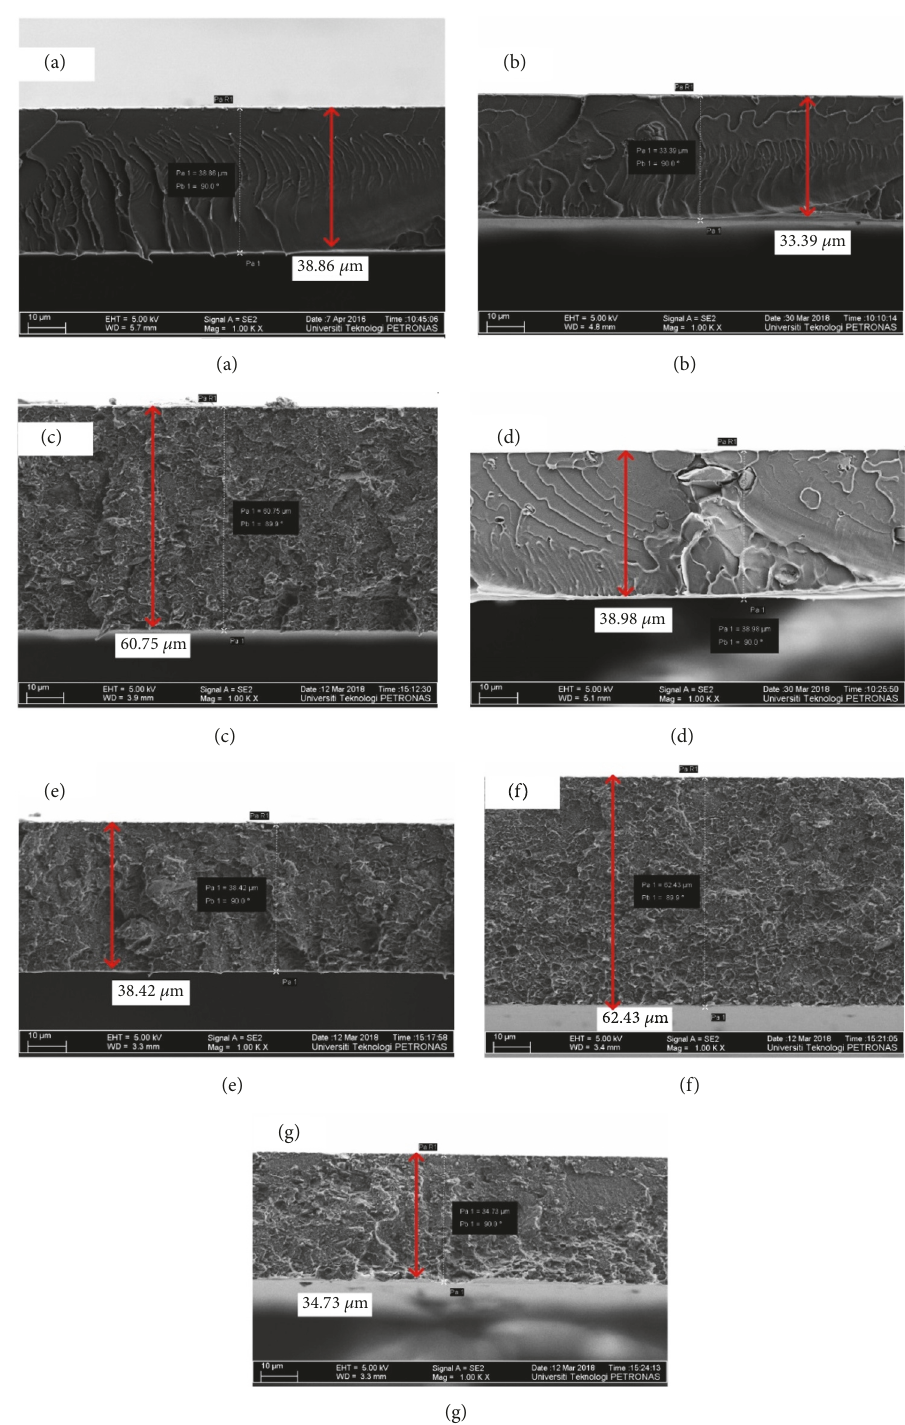
Figure 4: Cross-sectional membrane morphology of prepared membrane with (a) Pure PC, (b) PC-Sil, (c) 1.0:0.5, (d) 1.0:1.0, (e) 1.0:1.5, (f) 1.0:2.0, and (g)